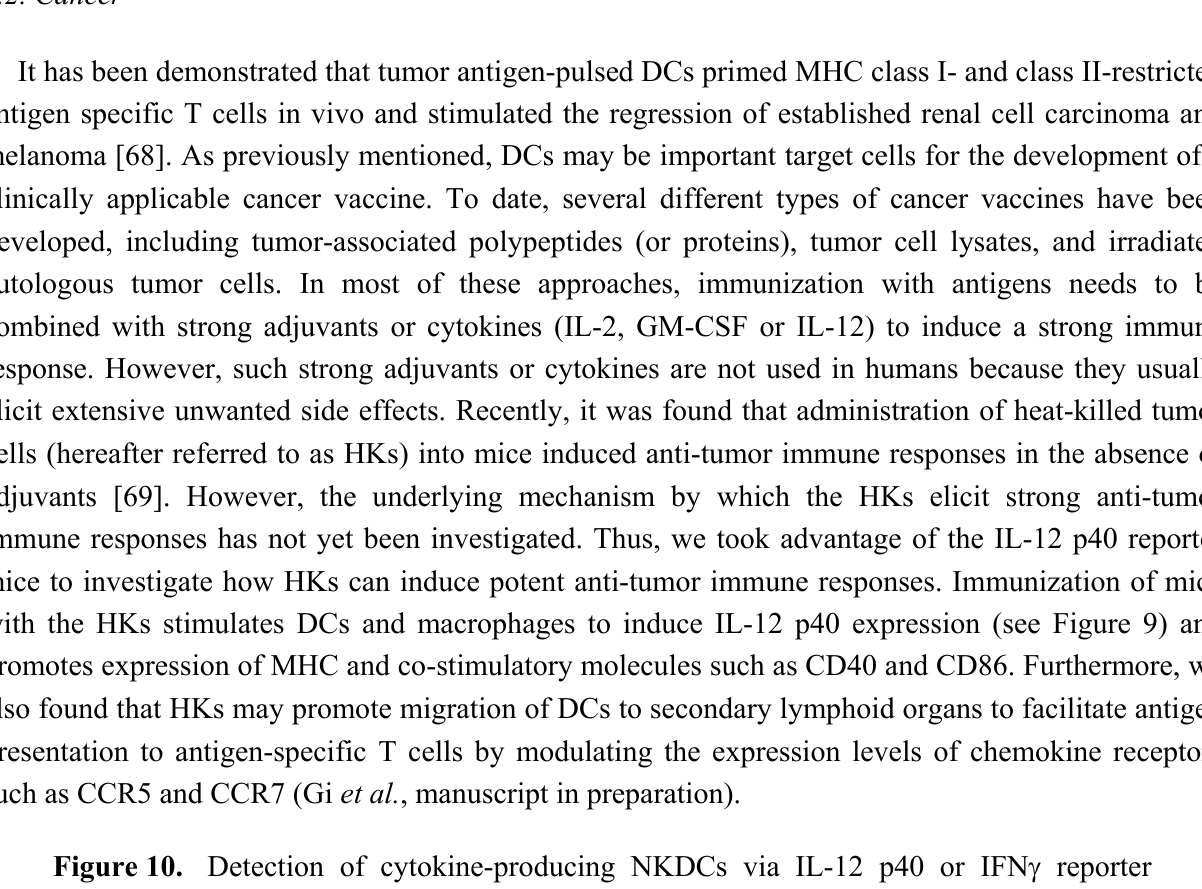
Figure 10. Detection of cytokine-producing NKDCs via IL-12 p40 or IFN γ reporter system. (a) Splenic DCs from IL-12 p40 reporter mice were isolated with MACS and subsequently stimulated with CpG for 16 hrs. On NK1.1 + CD11c + population gate, IL-12 p40 production was analyzed by flow cytometry and YFP expression. (b) BMDC